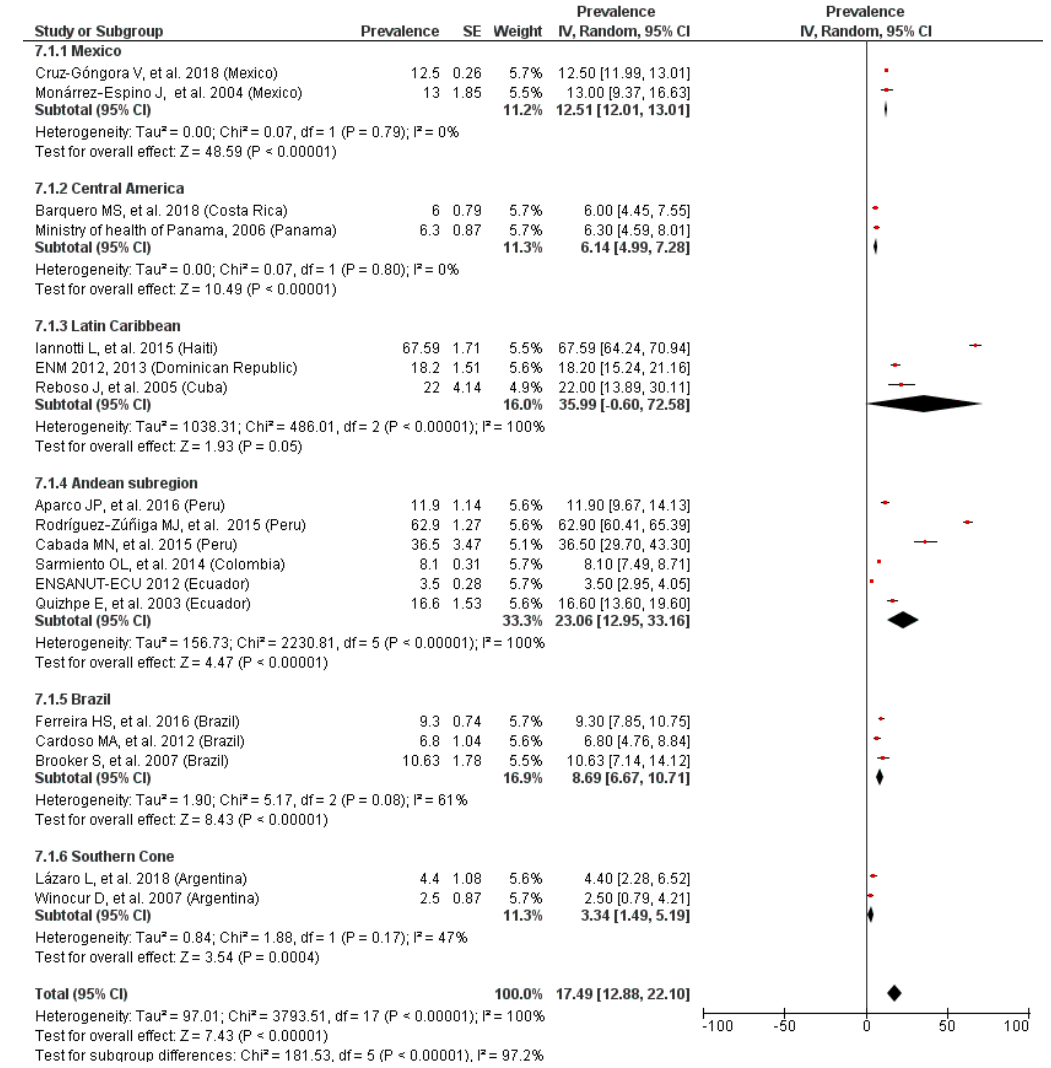
Figure 8. Prevalence of anemia in school-age children by LAC region.